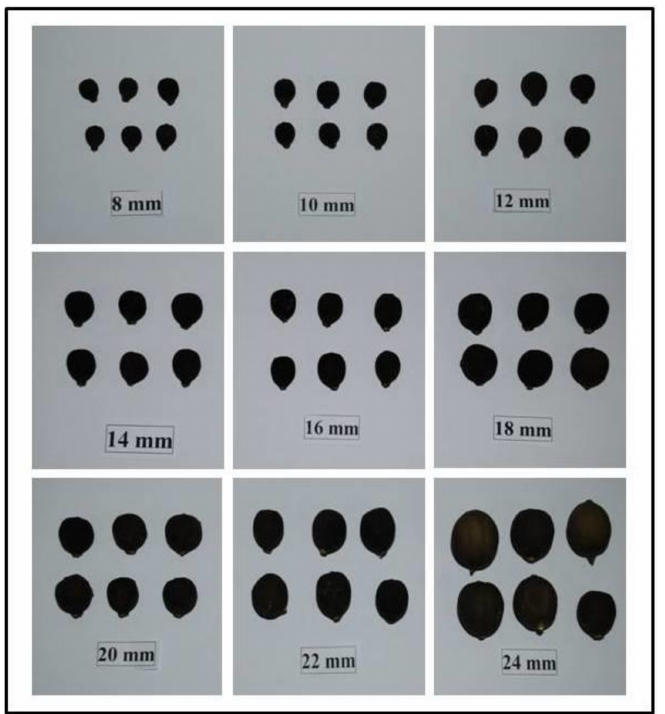
Figure 5. Physiologically dropped immature mandarin ( Citrus reticulata Blanco) fruits of varying sizes from 8–24